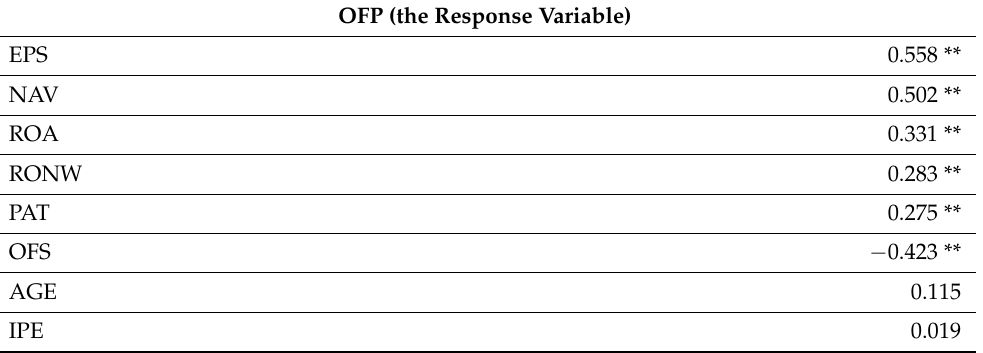
Table 5. Coefficients of